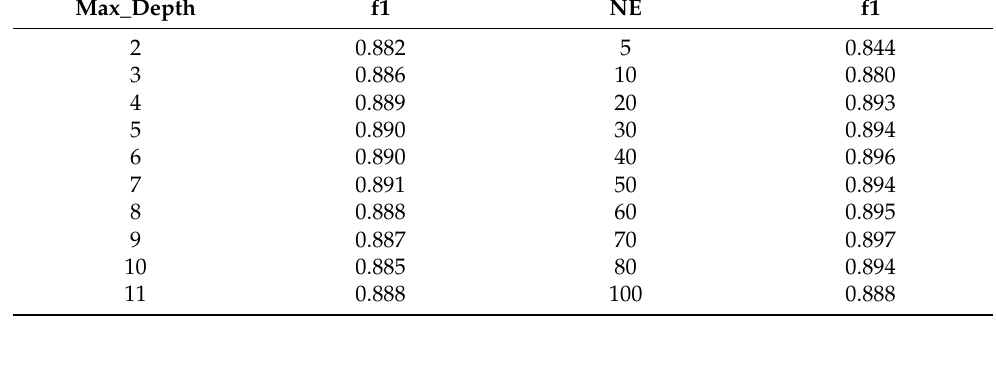
Table 7. XGBoost performance under different parameters.